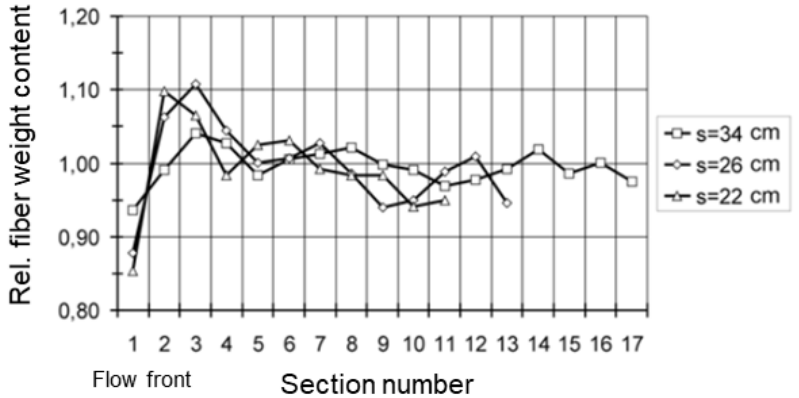
Figure 1. Relative change of fiber content distribution inside a compression molded sheet molding compound (SMC) plate from the melt front (1) to the initial charge position (17) with different flow length ‘s’ [5] .